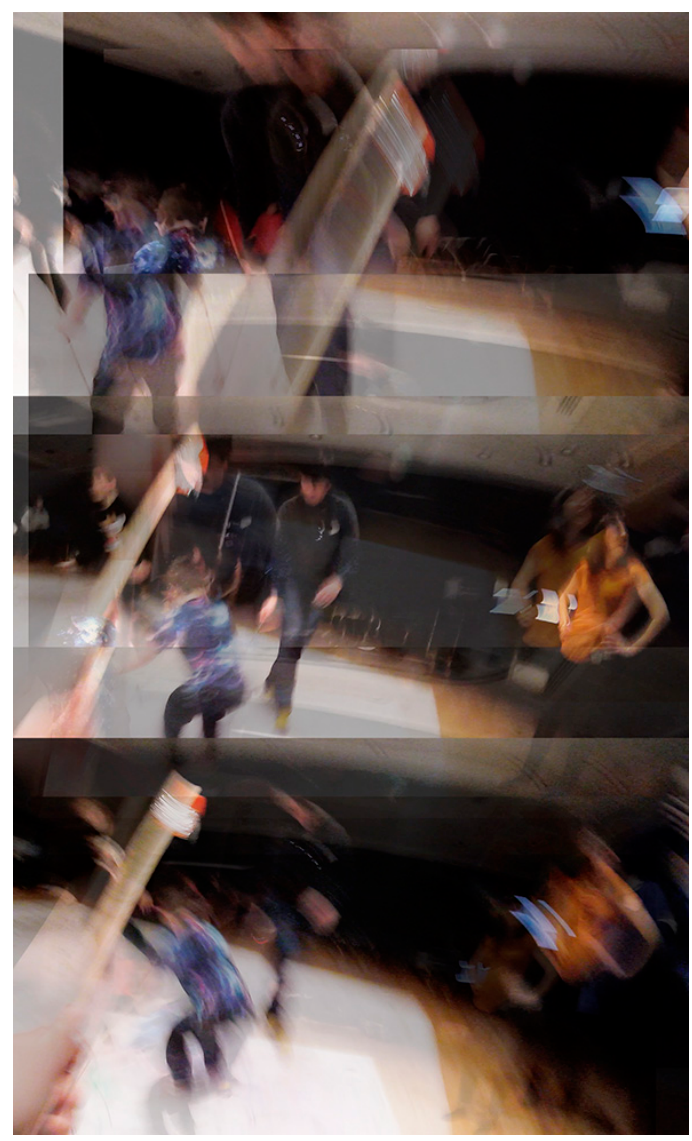
Figure 7. Sticks-markers-bodies-pixels-lights-speeds moving relations.